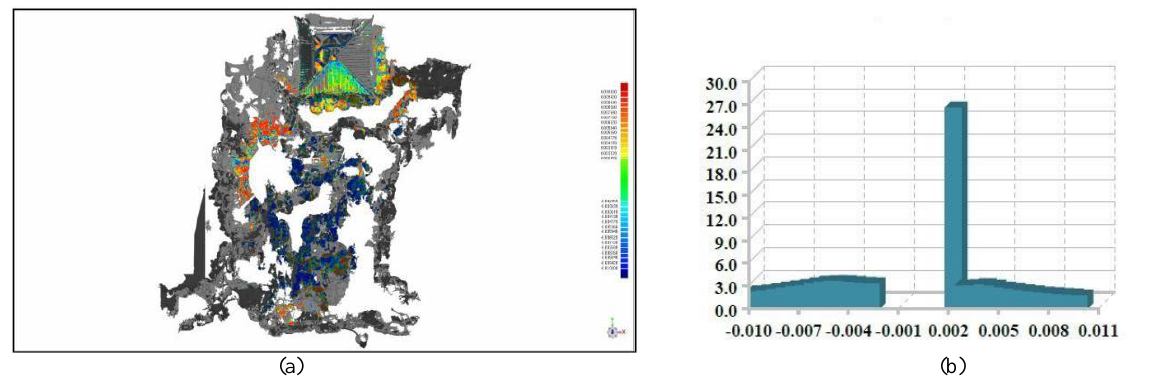
Figure 9. Top view and histogram after superposition (a) Top view of the model and point cloud overlay (b) Model and point cloud overlay